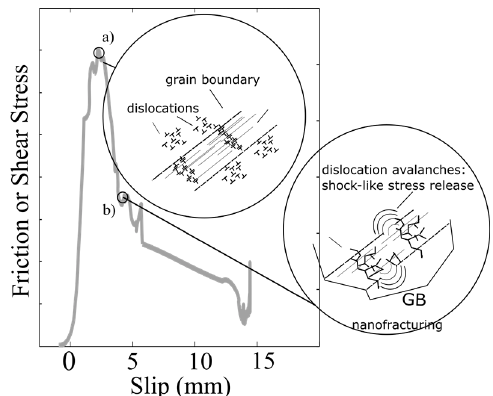
Figure 4. Evolution of microstructures and shear stress with slip. At slip initiation (panel a ), the asperities are strained: new dislocations are emitted and pile up at microstructural obstacles (e.g., cleavage planes, grain boundaries). With progressive slip (and strain, panel b ) the stress exerted by the piled-up dislocations overcomes the yield strength of the obstacle and the dislocations are released in “avalanches” causing brittle failure, formation of nano-grains, and temperature increase (flash heating) [20].